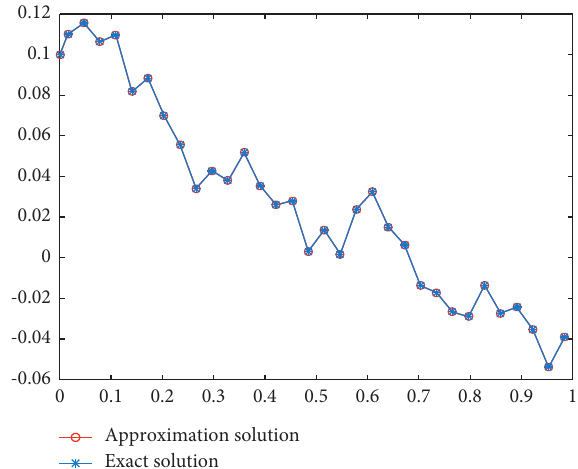
Figure 2: Simulation result of Example 1 for H � 0 . 6 and m �